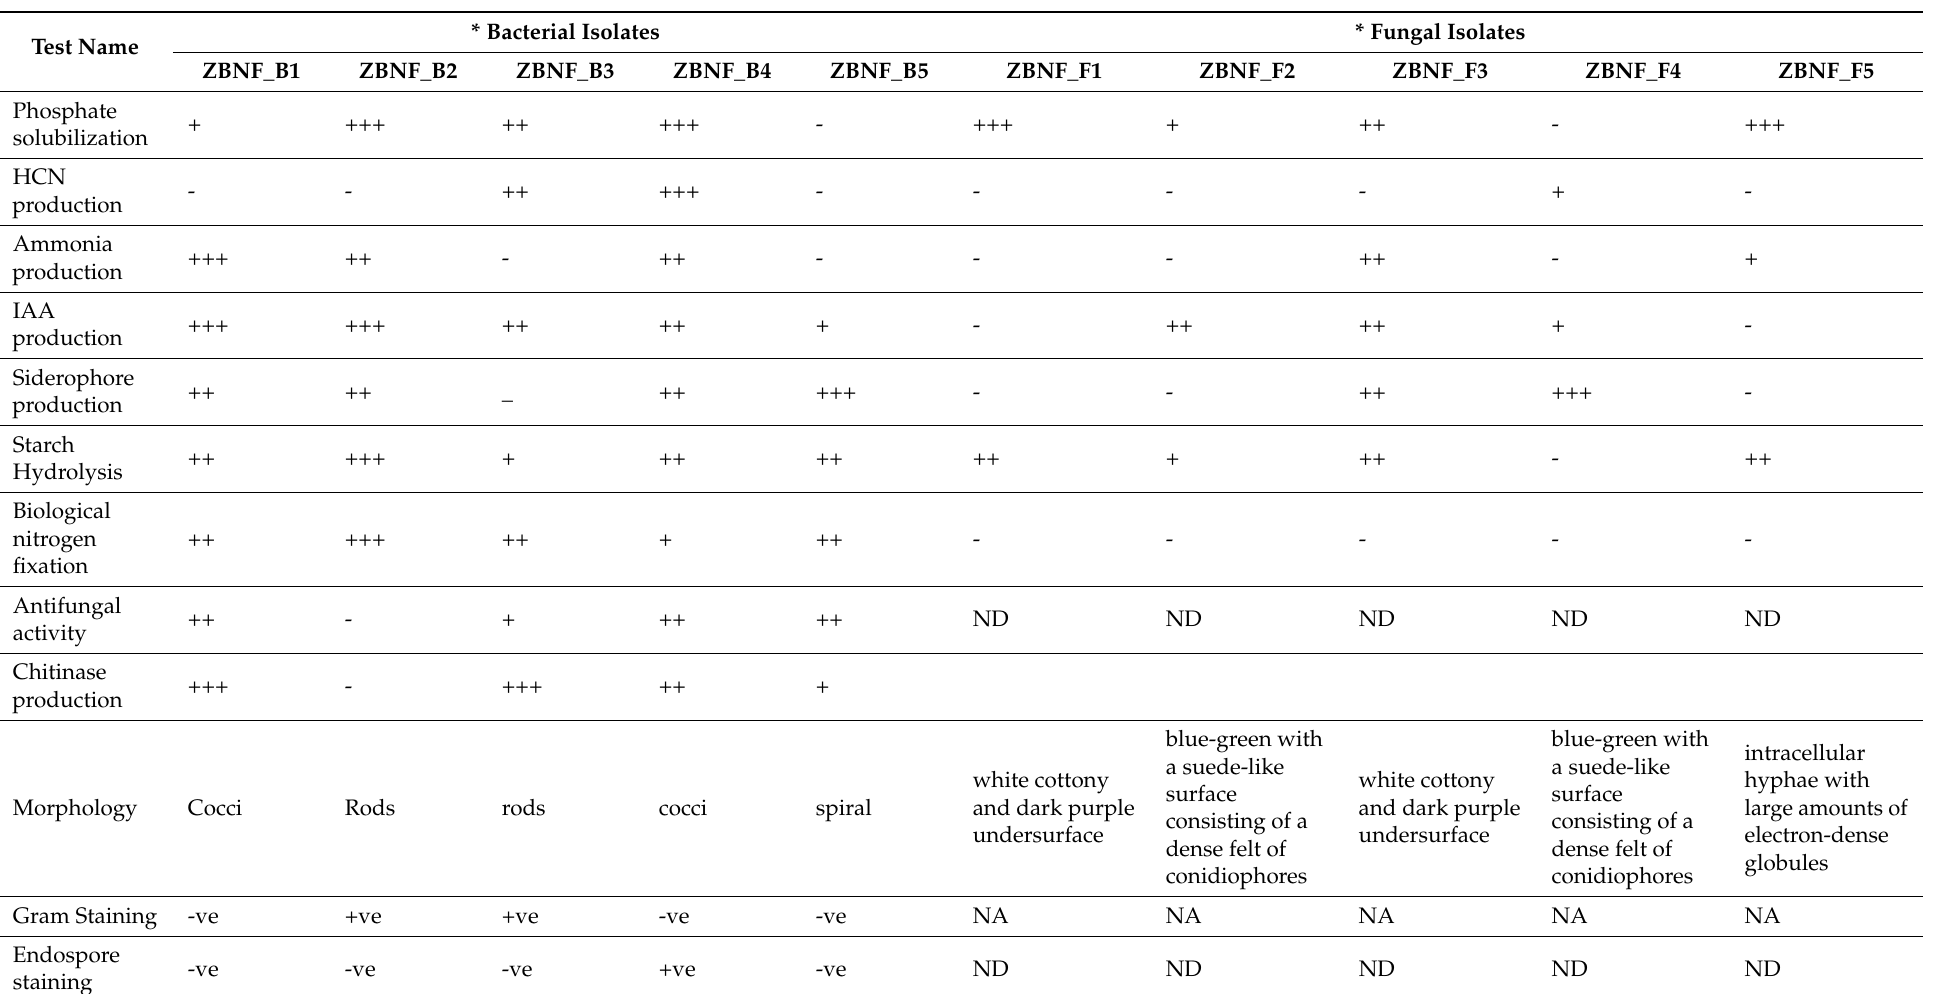
Table 3. Plant-growth-promoting activities shown by the isolated bacteria and fungi from ZBNF field